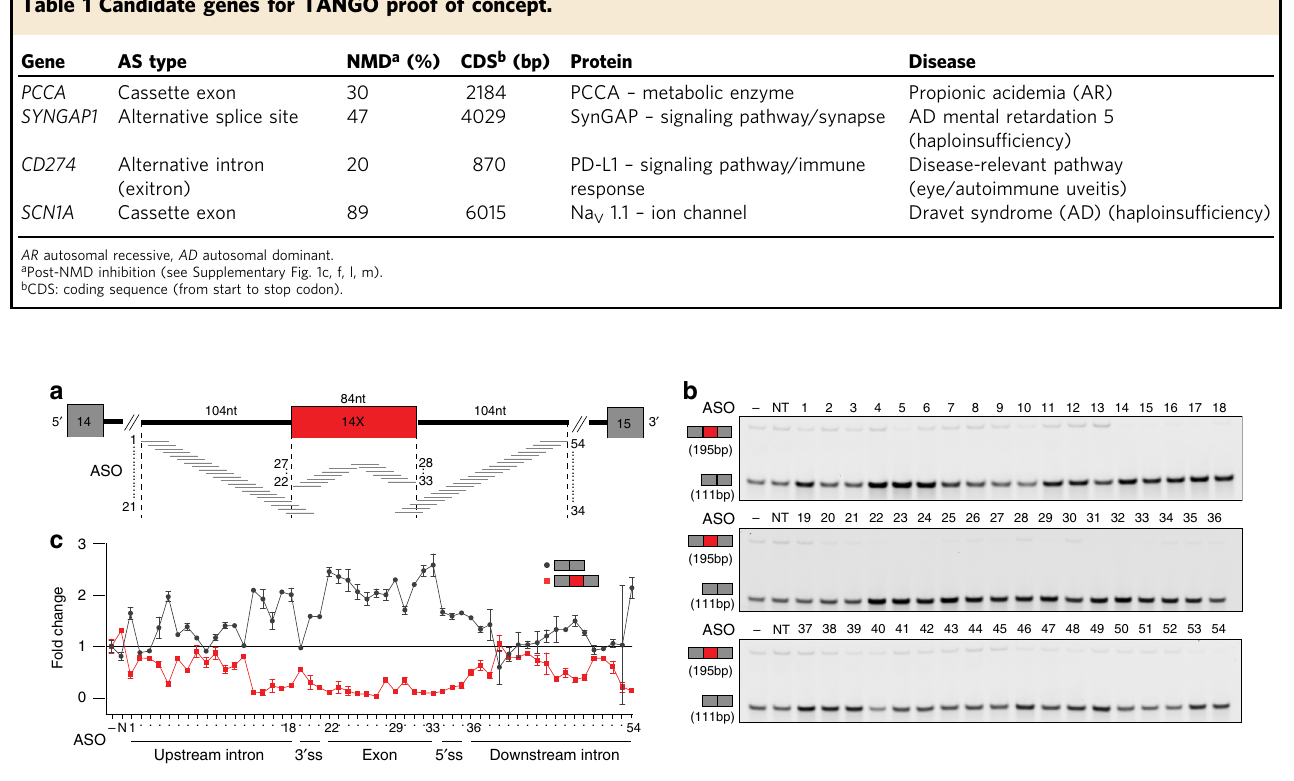
Fig. 2 ASO walk targeting the NMD-inducing exon inclusion in PCCA . a Diagram of ASO walk. The target region spans 104 nt of intronic sequences on each side of the non-productive alternative exon 14X, the exon – intron boundaries and exon 14X. Black lines denote introns, gray rectangles denote constitutive exons, and red rectangle denotes non-productive alternative exon. b A representative RT-PCR PAGE from HEK293 cells transfected with a total of 54 18-mer ASOs (shown in panel a ) and a non-targeting ASO control (NT) at 80 nM concentration or no-ASO mock control ( − ) for 24 h. The top band (195 bp) corresponds to the non-productive mRNA that results from the inclusion of exon 14X and the bottom band (111 bp) corresponds to the productive mRNA that results from the skipping of exon 14X ( n = 2 biologically independent samples over two independent experiments). c Graph depicting the fold increase over no-ASO mock control ( − ) of PCCA productive mRNA determined by TaqMan qPCR (gray circles, n = 2) and the fold decrease of PCCA non-productive mRNA based on densitometric quanti fi cation of RT-PCR products (red squares, n = 2) from panel b . Data are presented as mean values ±SD. Results show an inverse correlation between the reduction of non-productive mRNA and the increase of productive mRNA. ASO sequences are in Supplementary Data 4. Source data are provided as a Source Data fi